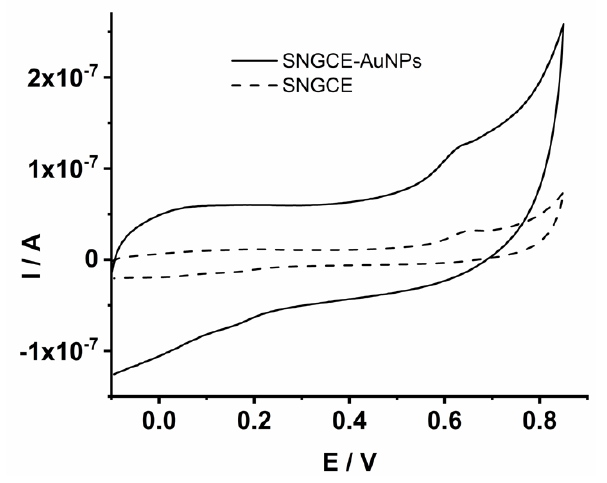
Figure 3. CVs recorded at SNGCE and SNGCE/AuNPs in 0.1 M PBS of pH 7 containing 20 µM MEL. Potential scan rate: 0.5 V s − 1 .